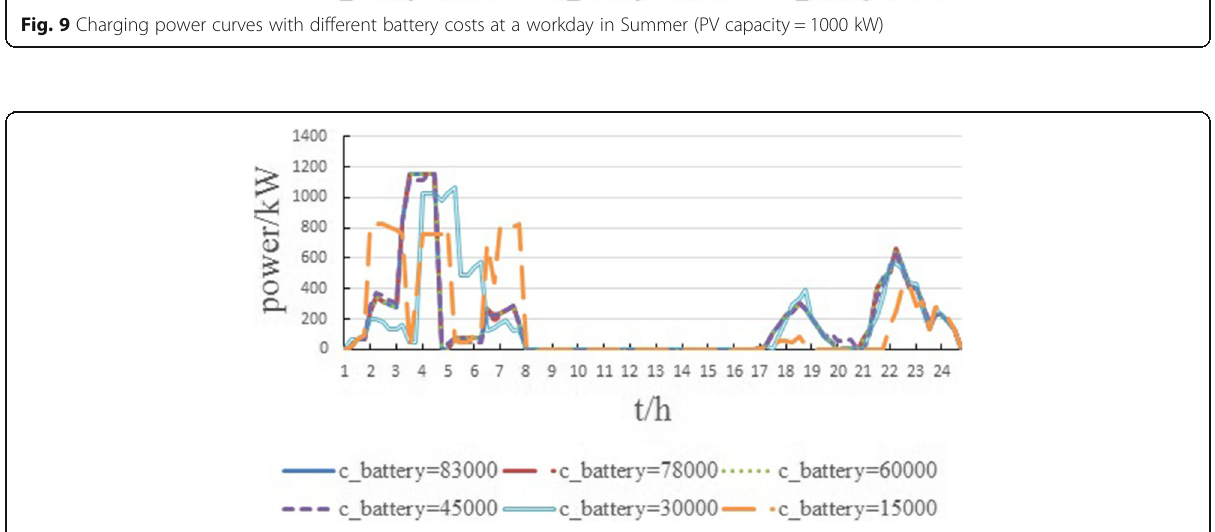
Fig. 10 System charging power curves with different battery costs at a workday in Summer (PV capacity = 1000